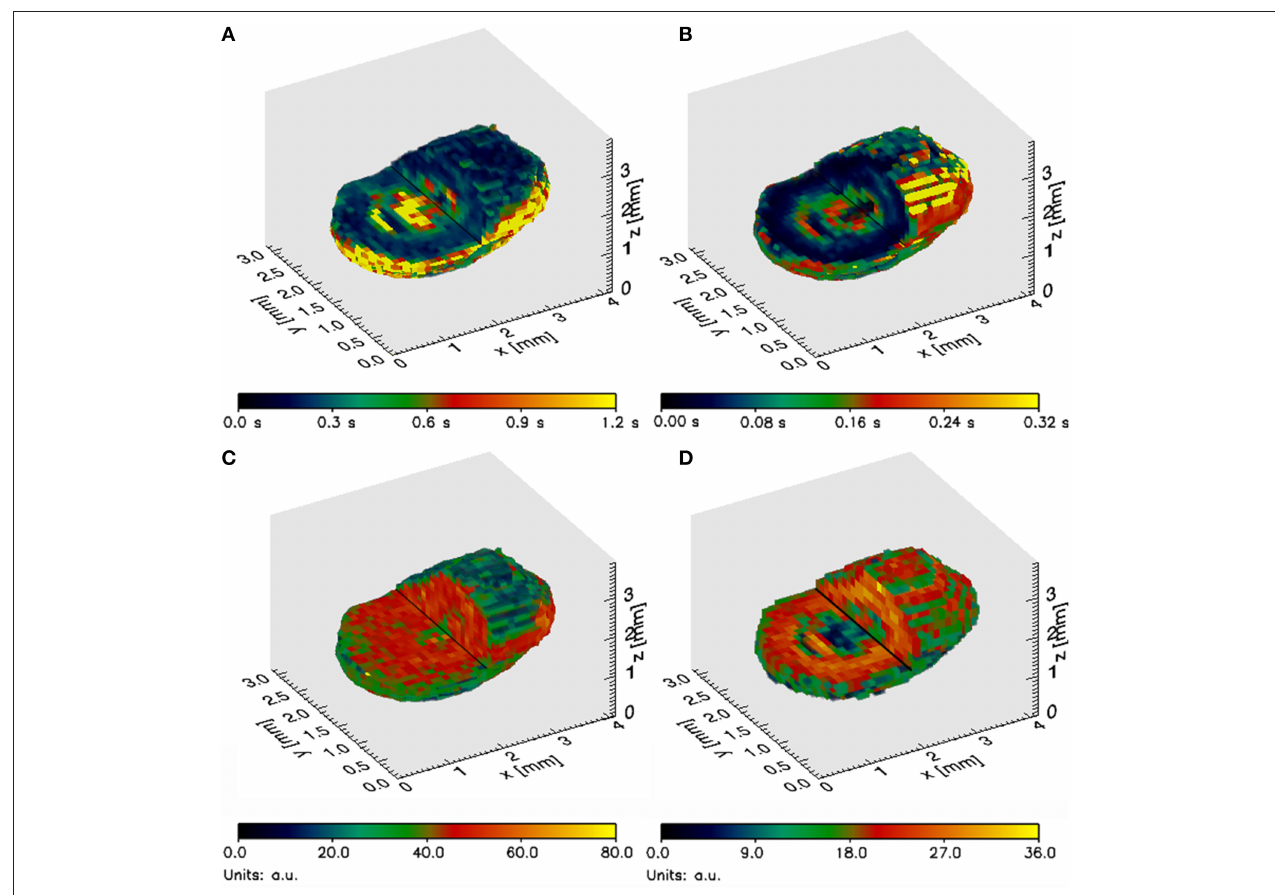
FIGURE 1 | Partial cross section of a typical methanogenic granule under investigation representing (A) 3D T 1 map, (B) 3D T 2 map, (C) 3D A 0 map and (D) 3D S